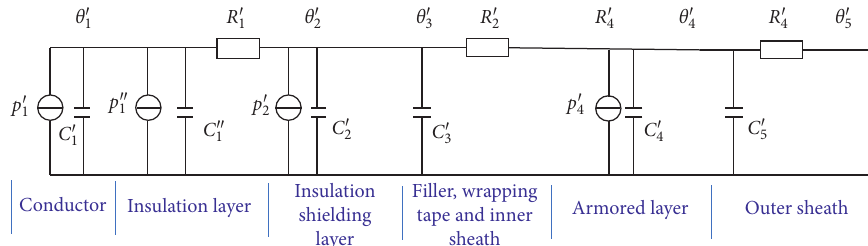
Figure 7: Thermal circuit model of power cable temperature